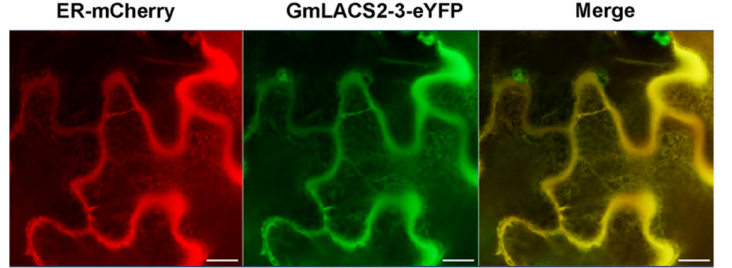
Figure 4. Subcellular localization of GmLACS2-3 through ER-mCherry, GmLACS2-3-eYFP, and Merge fluorescent protein-tagged markers. Scale bars = 10 µ